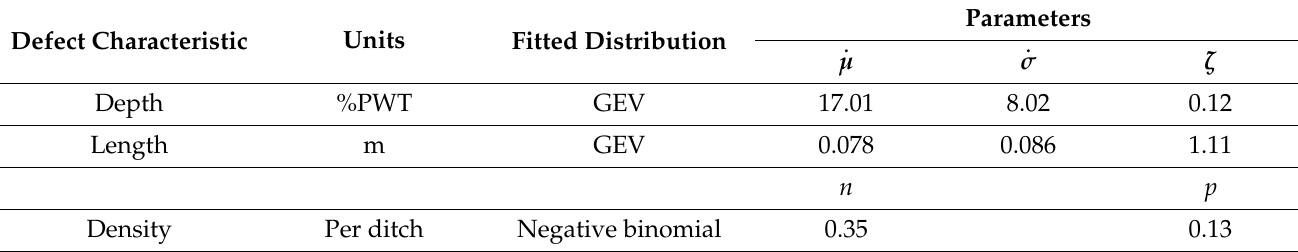
Table 4. Bayes-estimated parameters of the length and depth of corrosion defect and defect density in the studied pipeline